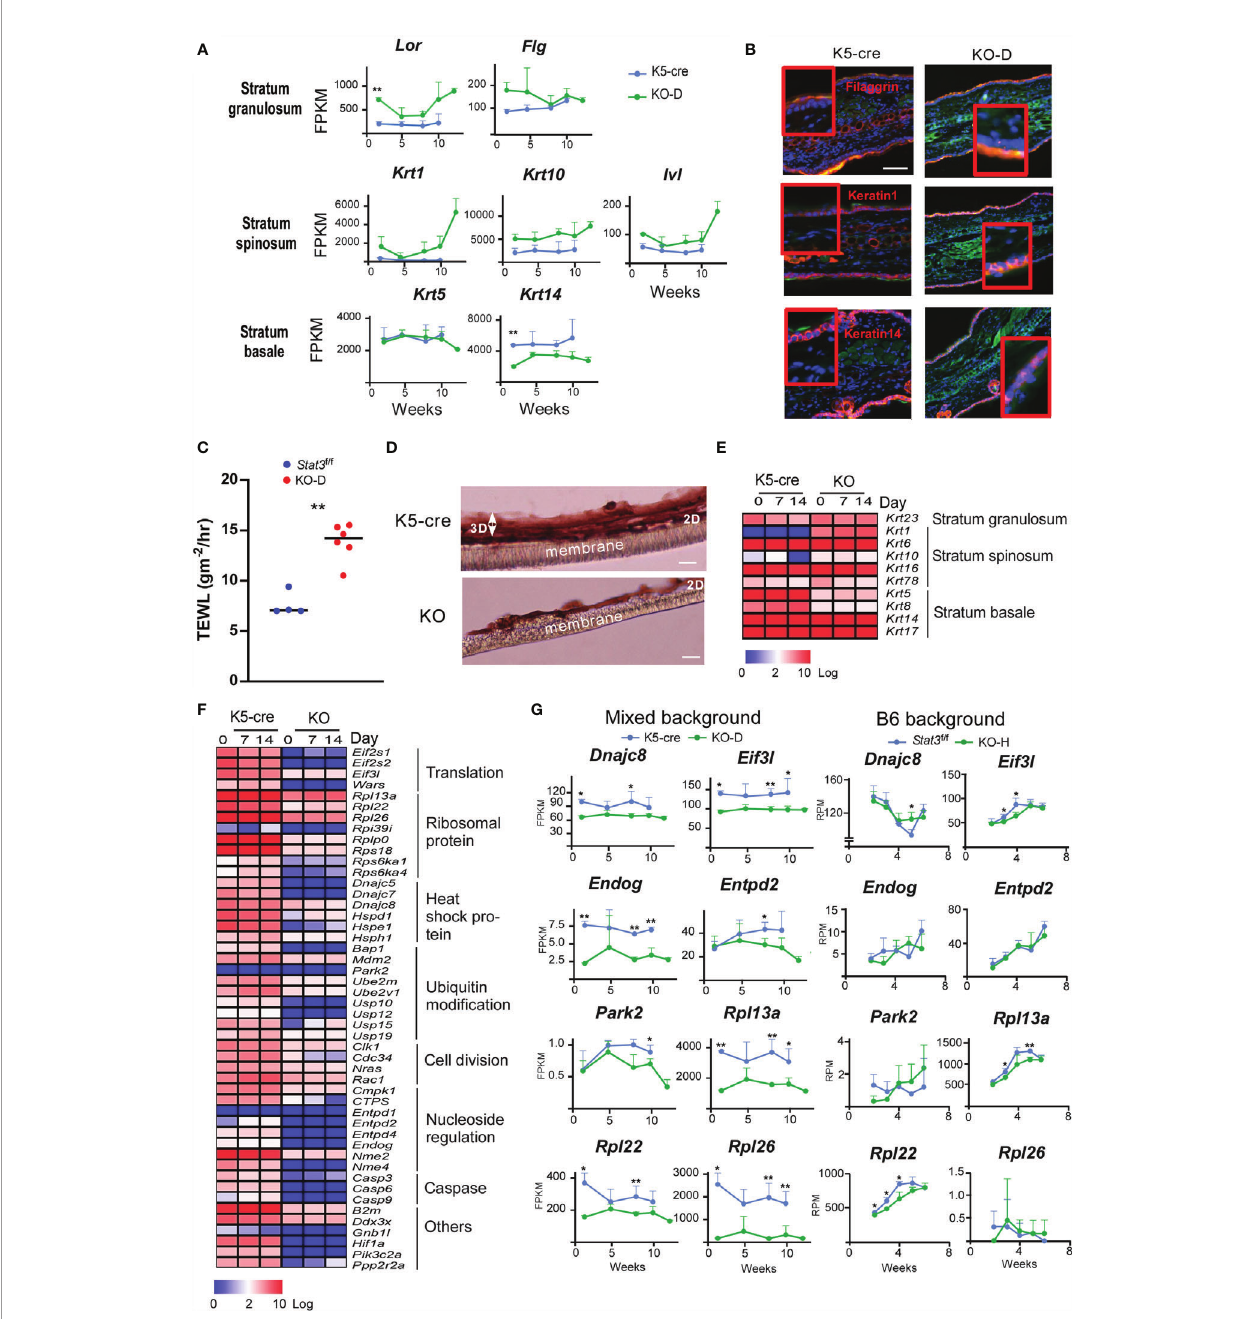
FIGURE 6 | Dysregulation of epidermal development in in vitro cultured Stat3 D K5 keratinocytes. (A) Time-dependent changes in in vivo mRNA expression of Lor , Flg , Krt1 , Krt10 , Ivl , Krt5 , and Krt14 are shown as lines for K5-cre (blue), and KO-D (green) mice. (B) Histological distribution of keratin 1 and 14, and fi laggrin protein in ear skin of WT and KO-D mice. Green and blue colors show Ki-67 expression and nuclei, respectively. (C) Transepidermal water loss (TEWL) from the ear of mixed background Stat3 f/f (n=4) or Stat3 D K5 (n=5) mice was measured at 16 weeks of age. (D) Hematoxylin and eosin staining of 3D-cultured keratinocytes (day 14). Keratinocytes were isolated from mixed background Stat3 -suf fi cient (K5-cre) or de fi cient (KO) newborn mice. After 3 days of culture in liquid medium (2D-culture), keratinocytes were induced to undergo 3D skin structure formation by exposing the apical layer to air, and cells were cultured for another 7 or 14 days. (E) Heatmap depicting in vitro keratin gene expression in 2D (day 0) and 3D (day 7 and 14) cultures. (F) Heatmap depicting in vitro cell proliferation-related gene expression in 2D (day 0) and 3D (day 7 and 14) cultures. (G) Time-dependent changes in gene expression of Dnajc8 , Eif3l , Endog , Entpd2 , Park2 , Rpl13a , Rpl22 , and Rpl26 in the ear skin of mixed background (left) or B6 background (right) Stat3 -suf fi cient (K5-cre for mixed background, Stat3 f/f for B6 background) and de fi cient (KO) mice are shown as lines for Stat3 -suf fi cient (blue, n=4) and Stat3 -de fi cient (KO, green, n=4) mice. Scale bar = 100 m m. *p<0.05,